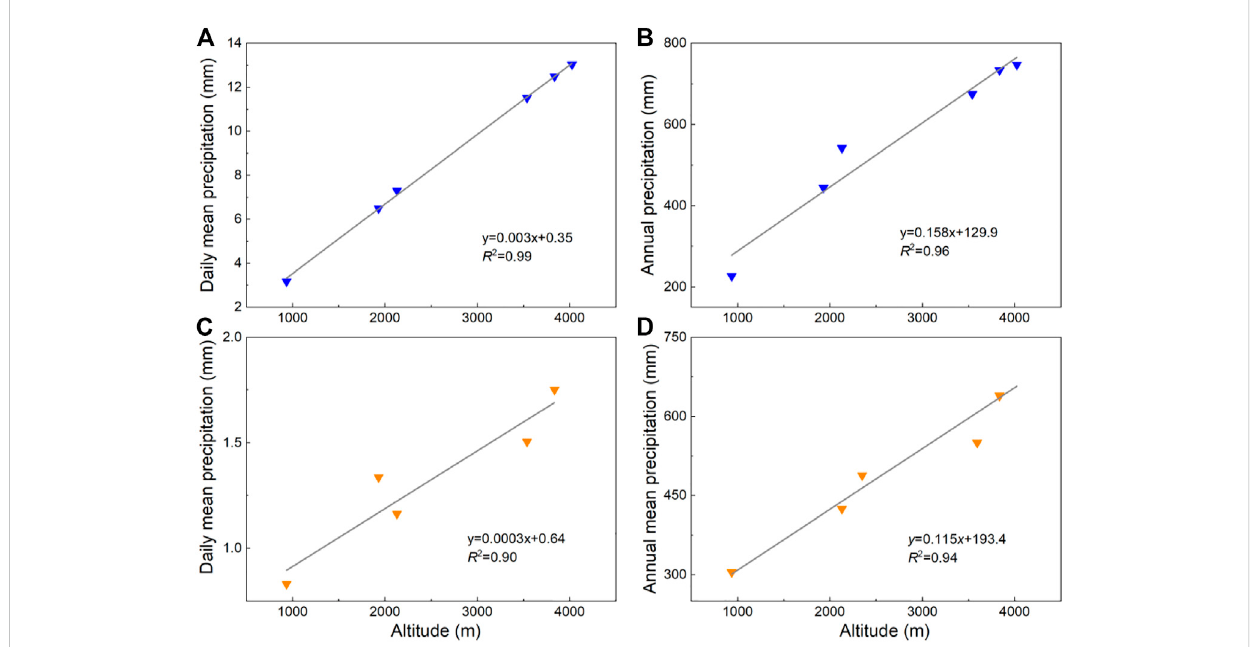
FIGURE 8 Variations of average daily precipitation (A) and annual precipitation (B) along with an altitude in 2019 and daily mean precipitation (C) and annual mean precipitation (D) during 2011 – 2019.